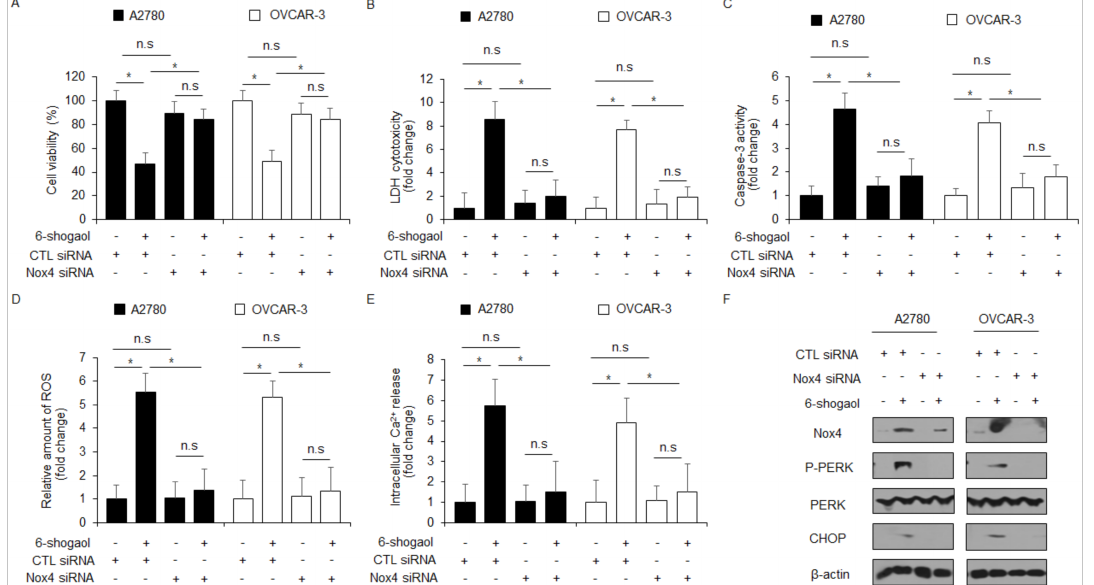
Figure 6. DPI and NAC suppresses cell death in 6-shogaol-treated ovarian cancer cells. ( A ) The fluorescence data indicate intracellular ROS production by DCFDA dye in 6-shogaol (0, 8, 16, and 24 h; 30 µ M)-treated A2780 and OVCAR-3 cells. ( B – G ) A2780 and OVCAR-3 cells were pretreated with DPI (1 µ M) and NAC (100 µ M) for 4 h and subsequently treated with 6-shogaol (30 µ M, 24 h). WST-1, LDH cytotoxicity assay, caspase-3 activity assay, ROS assay, intracellular Ca 2+ assay, and Western blotting analyses were performed; *, p < 0.05. n.s = not significant. Western blot showing p-PERK, PERK, ATF4, and CHOP levels was carried out using these samples. β -actin was used as the protein loading control.